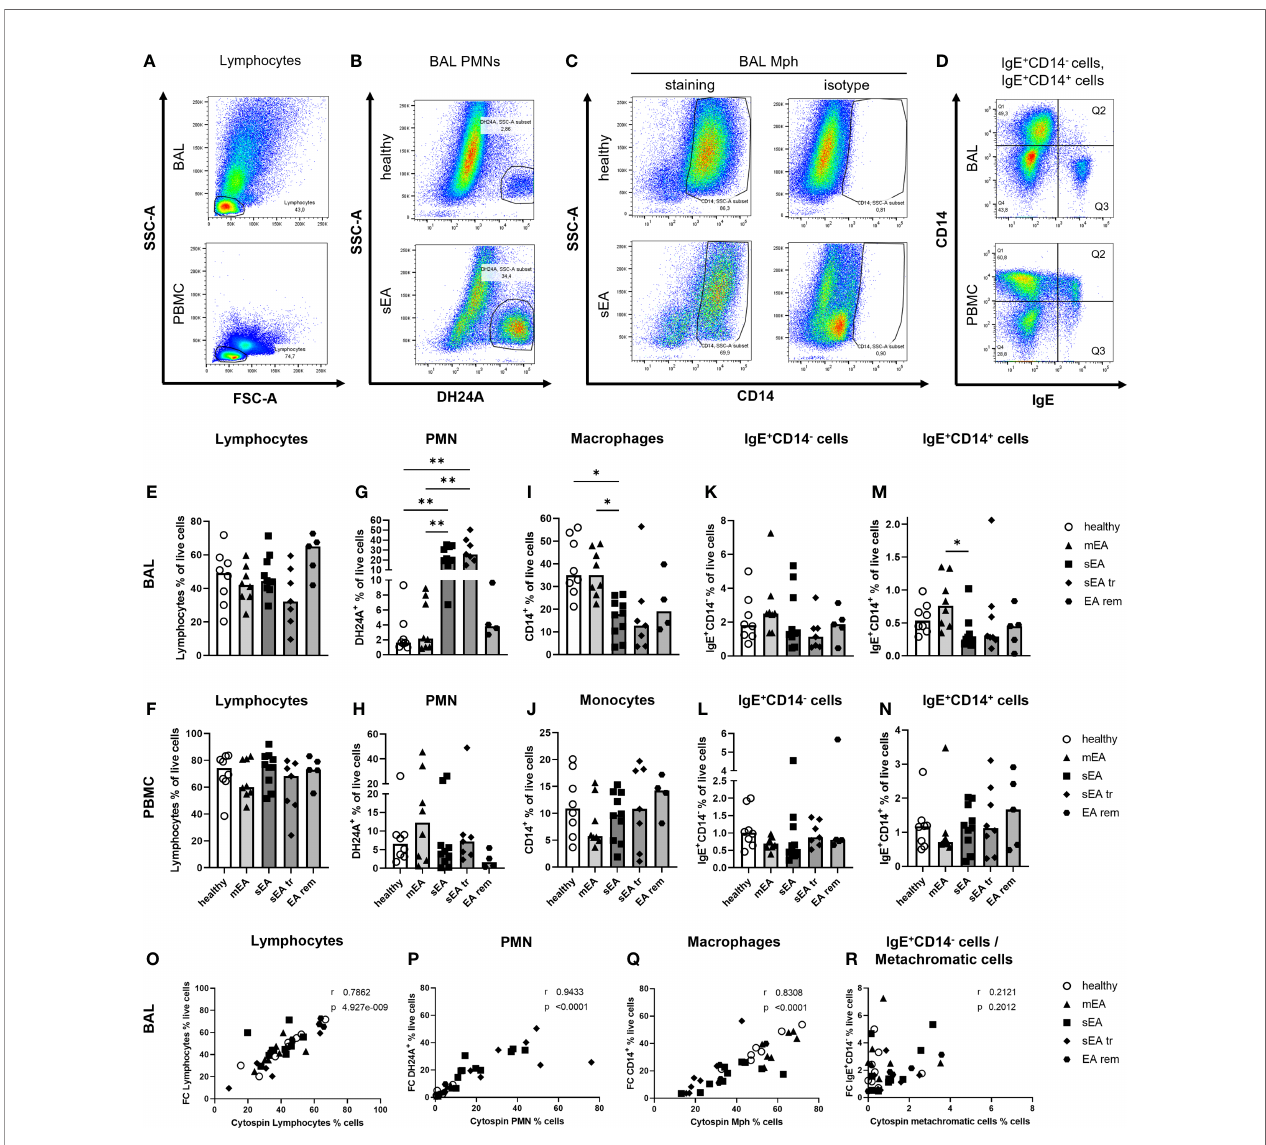
FIGURE 2 | Flow cytometry analysis identi fi es all major cell populations and con fi rms increased PMN frequencies in BAL from horses with severe equine asthma (sEA). Representative pseudocolor plots (A – D) indicate the gating strategy in different samples ( A, D : BAL cells or PBMC, sEA) or illustrate differences between groups ( B, C ; healthy or sEA, BAL cells). Singlet live cells were gated as shown in Supplementary Figure 2 and (A) Lymphocytes were gated by FSC-SSC characteristics. After their exclusion, the other cell populations were gated from the non-lymphocyte fraction: (B) PMN were identi fi ed by staining with antibody clone DH24A, and (C) macrophages (Mph)/monocytes by CD14 expression. (D) CD14 - IgE + (Q3), and (D) CD14 + IgE + (Q2) cells were quanti fi ed. (E – N) . Frequencies of the main cell populations in BAL cells or PBMC were calculated as fractions of all live cells and are plotted by groups. Results from individual horses are shown, with bars indicating median group values. Asterisks represent differences between groups with p<0.05 in Kruskal-Wallis tests. Lymphocyte percentages were similar in (E) BAL, or (F) PBMC of horses from all groups. Frequencies of (G) PMN in BAL of horses with sEA and sEA tr (pre-treated horses with sEA) were higher compared to healthy horses. In contrast, CD14 + Mph frequency was decreased in (I) BAL from horses with sEA. Percentage of IgE + CD14 - cells among live cells did not differ between groups in (K) BAL and (L) PBMC. Proportions of IgE-binding CD14 + cells (IgE + CD14 + ) were increased in (M) BAL cells from horses with mEA compared to the sEA group. The frequencies of the cell populations in PBMC were similar between all groups. EA rem (equine asthma in remission). (O – R) Comparisons of cytology differentiation (Cytospin) and fl ow cytometric (FC) analysis reveal signi fi cant correlation of percentages of (O) lymphocytes, (P) PMN, (Q) Mph, but not (R) metachromatic cells (MC) and IgE + CD14 - cells. Spearman r and p are monocyte/Mph marker CD14 (lipopolysaccharide co-receptor markers of equine BAL Mph (11, 30), was performed on some (17, 18),), and CD16 (Fc g RIIIa), which has been described and BAL samples and the majority of the putative Mph (70-90% of used as a non-classical monocyte marker (12, 17). Staining of DH24A - NL) were positive for both, CD14 and CD206 or CD14 mannose receptor CD206 and scavenger receptor CD163, other and CD163 (data not shown). Due to less interference with Mph